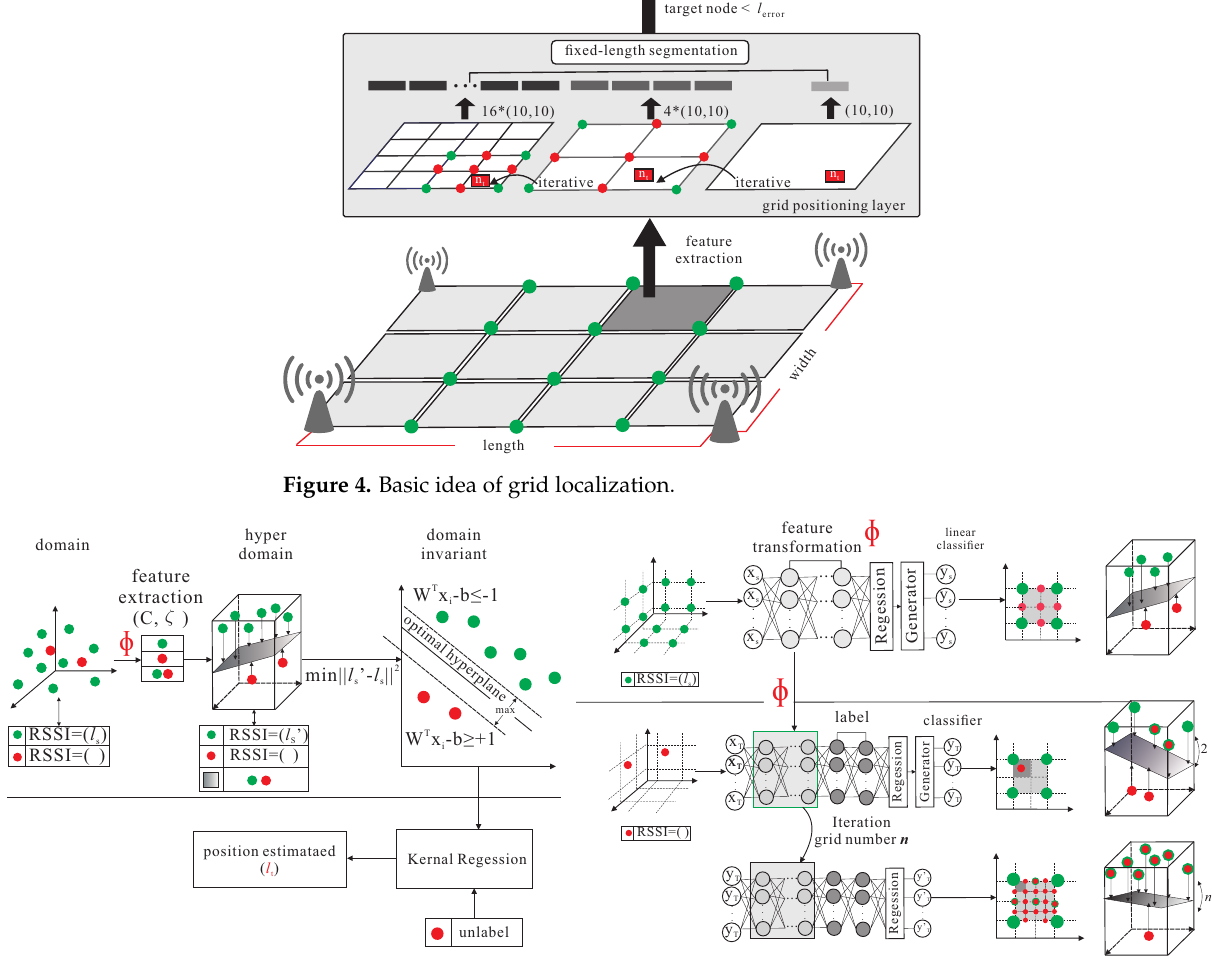
Figure 5. Comparison with ( a ) transfer kernel learning based on SVM; ( b ) transfer learning with grid segmentation based on